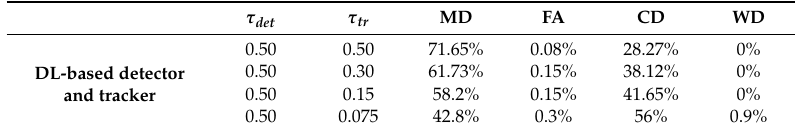
Table 7. DL-based detector and tracker performance as a function of τ tr ( τ det = 0.50). FT1-B composed of 1330